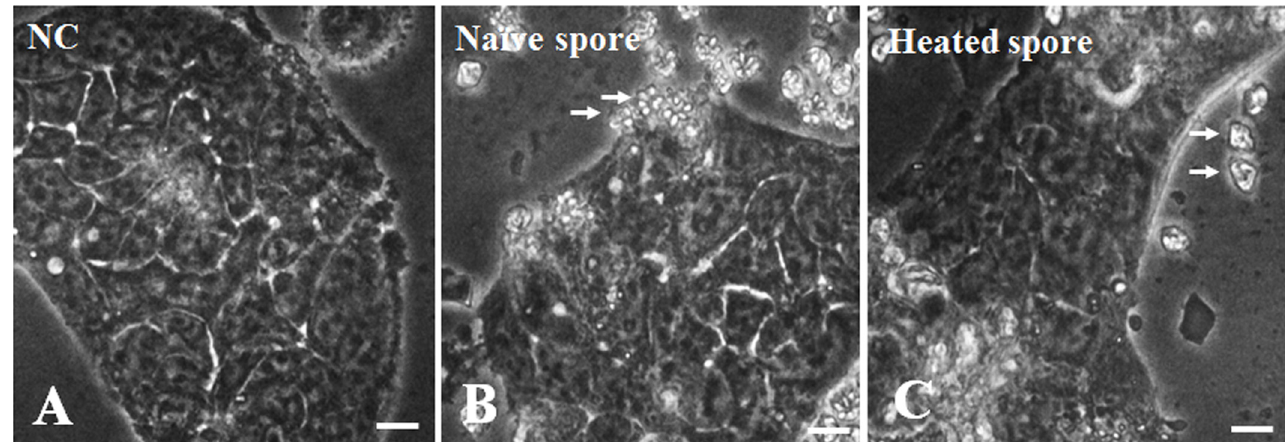
Figure 3. Microscopy of naïve and heated spores of Kudoa septempunctata in Caco-2cells. (A) Vehicle-treated negative control, (B) naïve spores (arrows), and heated spores (arrows) exposed to Caco-2 cells. Scale bars, 50 m m.